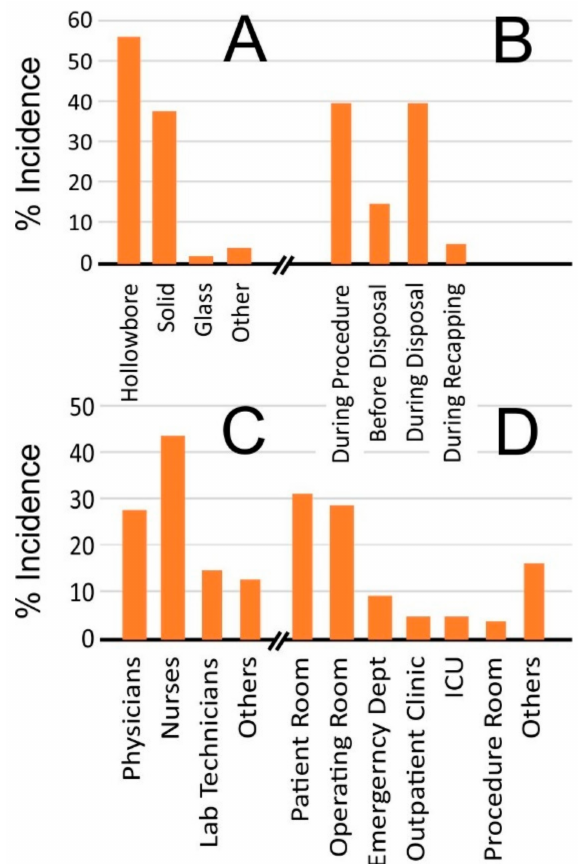
Figure 1. Incidence of needlestick injuries by device type ( A ), process ( B ), person ( C ), and location ( D ). (Figures adapted from Reference